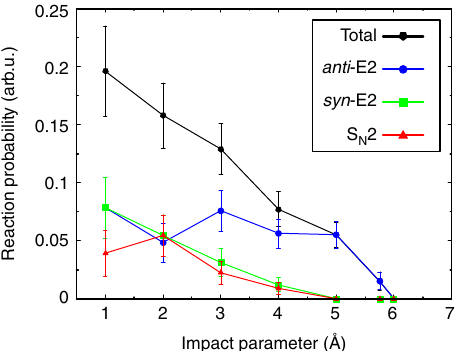
Fig. 5 Reaction probability of the three main reaction mechanisms as a function of impact parameter. The relative collision energy is set to 1.9 eV. The vertical error bars represent the statistical uncertainty in the reaction probability at each impact parameter, computed from the square root of the number of reactive events